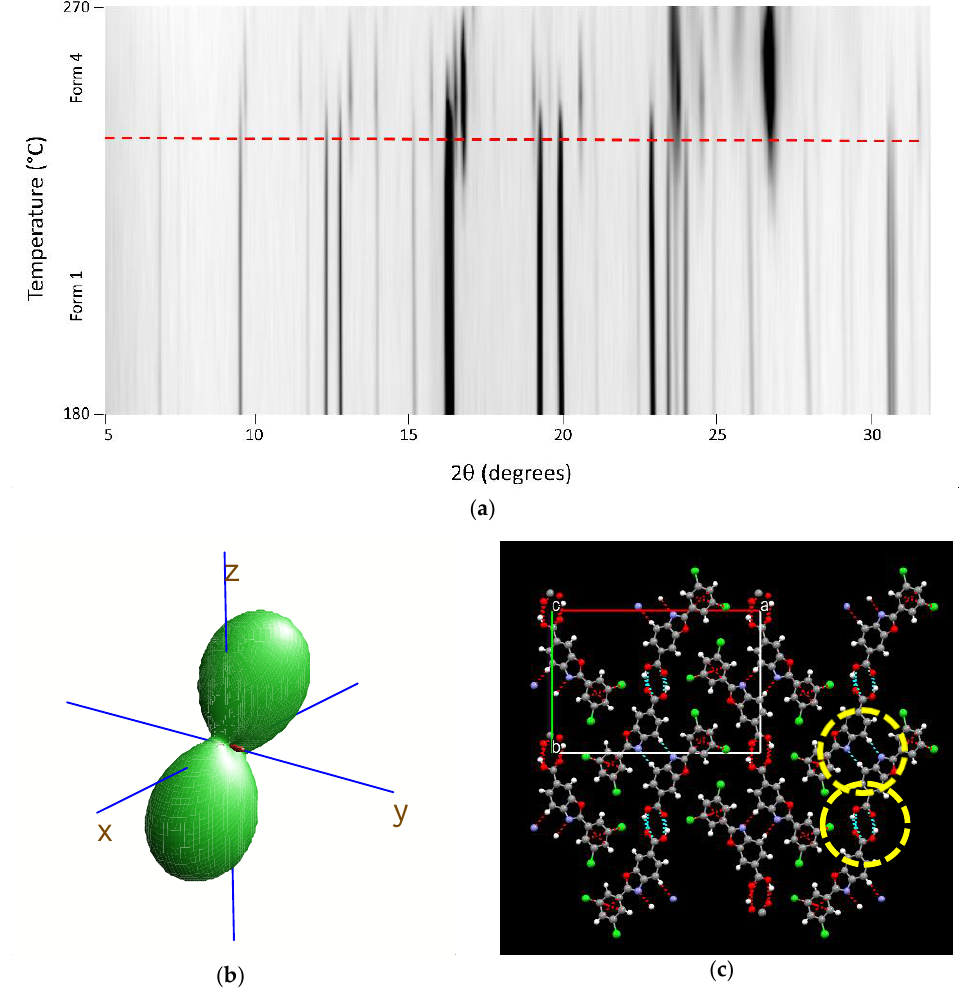
Figure 4. Variable-temperature X-ray diffraction (VTXRD) data (in the most relevant 180 – 270 °C range) showing the thermal evolution of the XRD pattern upon heating Tafamidis Form 1 in situ in the diffractometer cradle ( a ), showing its quantitative conversion into Form 4 at ca. 240 °C (red dashed line). ( b ) Visualization of the thermal strain tensor, showing nearly null (actually, slightly negative) thermal expansion in the y direction (see text), and ( c ), the hydrogen-bonded ribbons running along b . Indeed, couples of short O-H ··· O and C-H ··· N contacts, highlighted by the yellow circles, are responsible for the stiffness of the structure along b . Note that, for monoclinic symmetry, the y direction in the plot of the tensor isosurface is aligned with b, and that the xz plane corresponds to the crystallographic ac plane. Color codes in panel ( c ): C (grey); H (white), N (blue), O (red) and Cl (green).